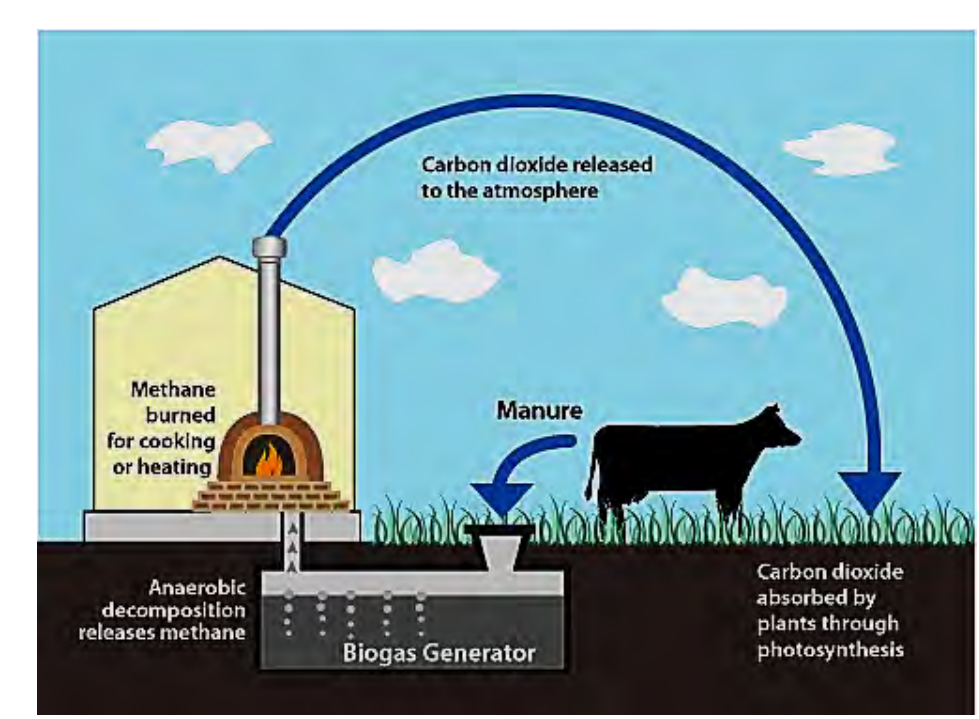
Figure 13. Usingcows manure to generate methane gas for cooking and heating